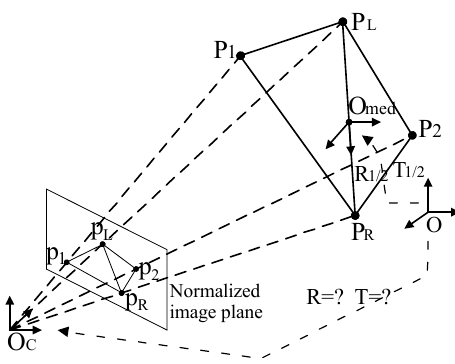
Figure 9. The projections of the vertices.